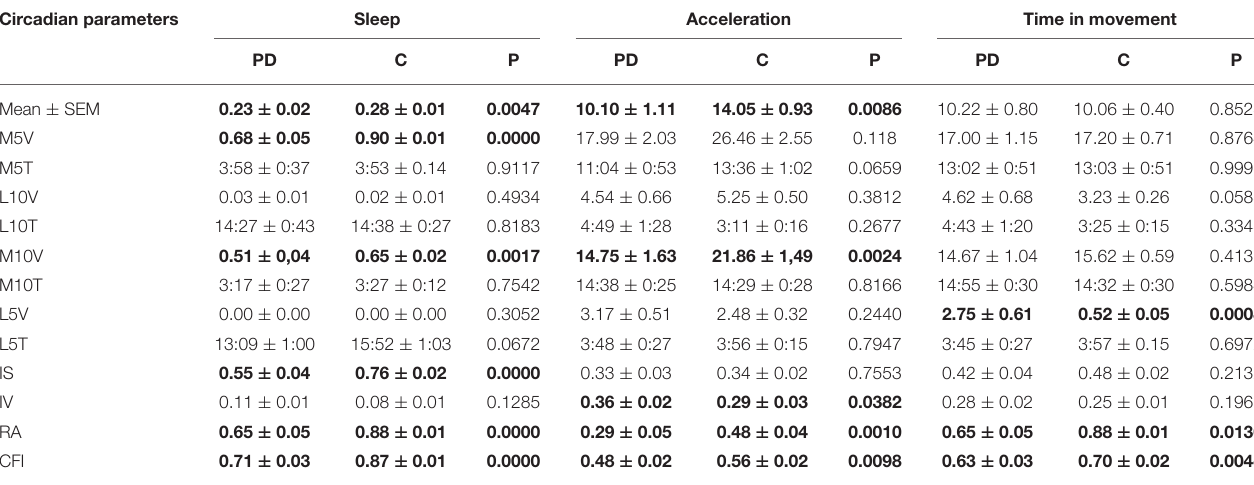
TABLE 3 | Circadian parameters of the probability of sleep, motor acceleration, and time in movement variables. Circadian parameters